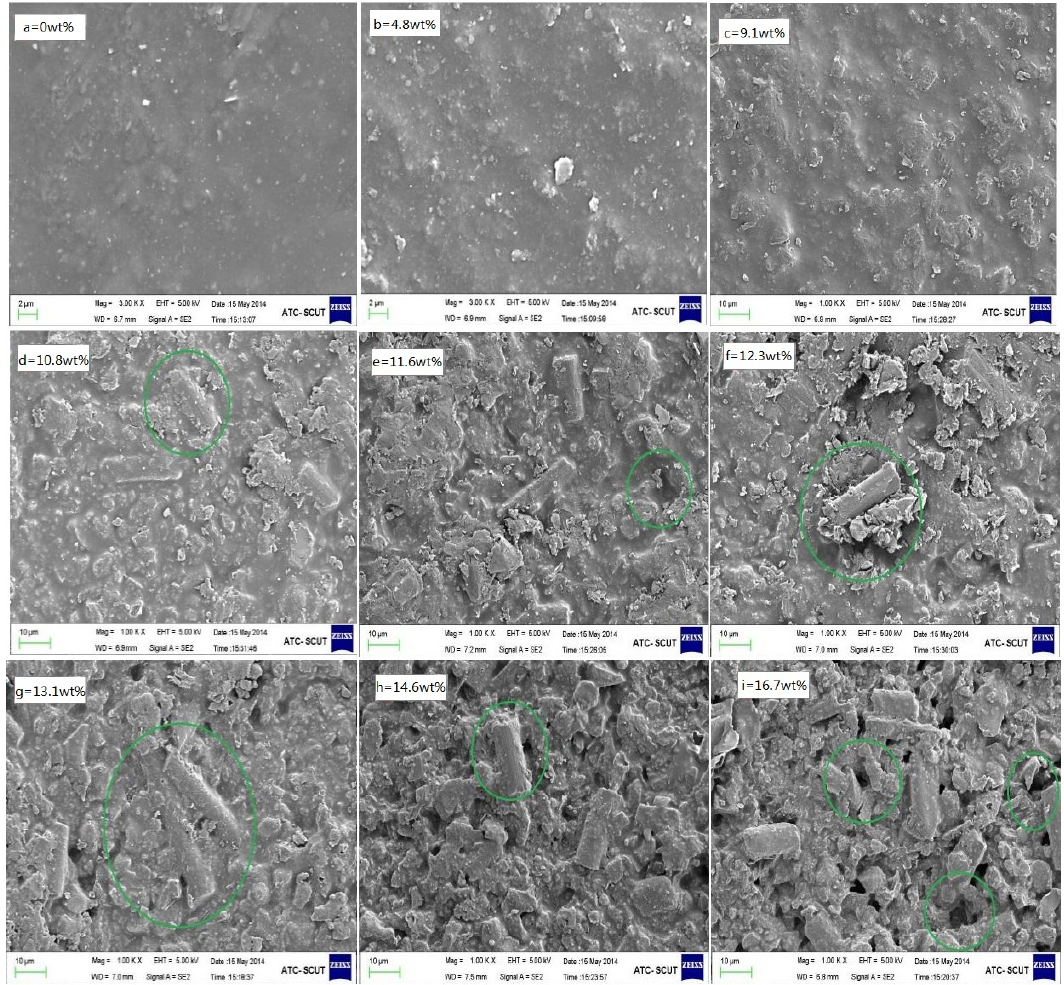
Figure 4. Scanning electron microscopy (SEM) micrographs of different mass percentages of CF.